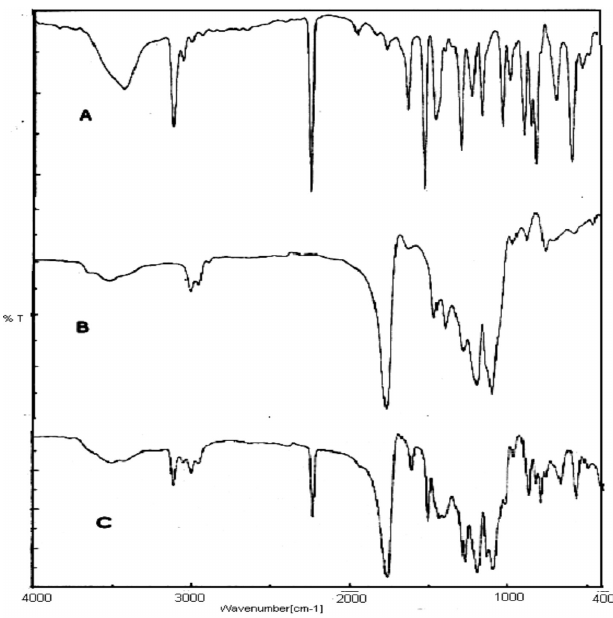
FIGURE 4 - Infrared spectra of pure LTZ (A), pure PLGA (B), LTZ /PLGA physical mixture 1:1 (C).